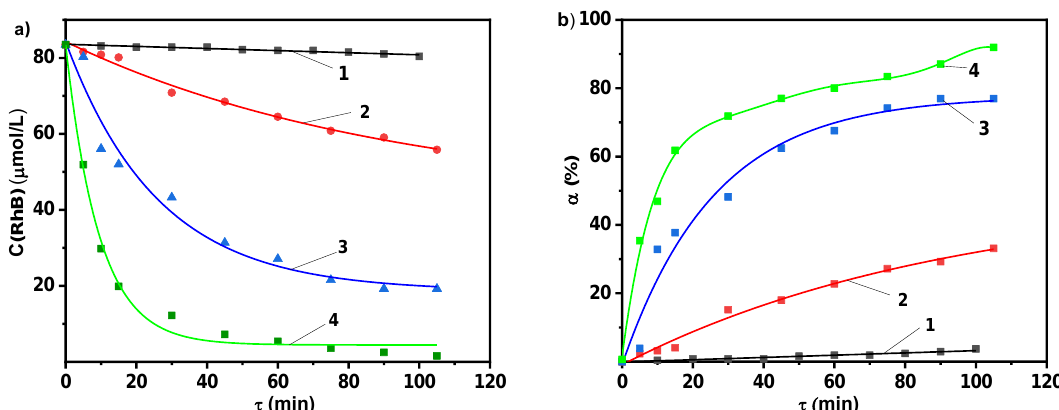
Figure 4. Kinetics ( a ) and e ffi ciency ( b ) of RhB destruction (initial concentration 40 mg / L): UV photolysis (1); UV photolysis in the presence of catalysts: TiO 2 -PMM (2), TiO 2 -PMMH (3) and TiO 2 -PAMMH (4).